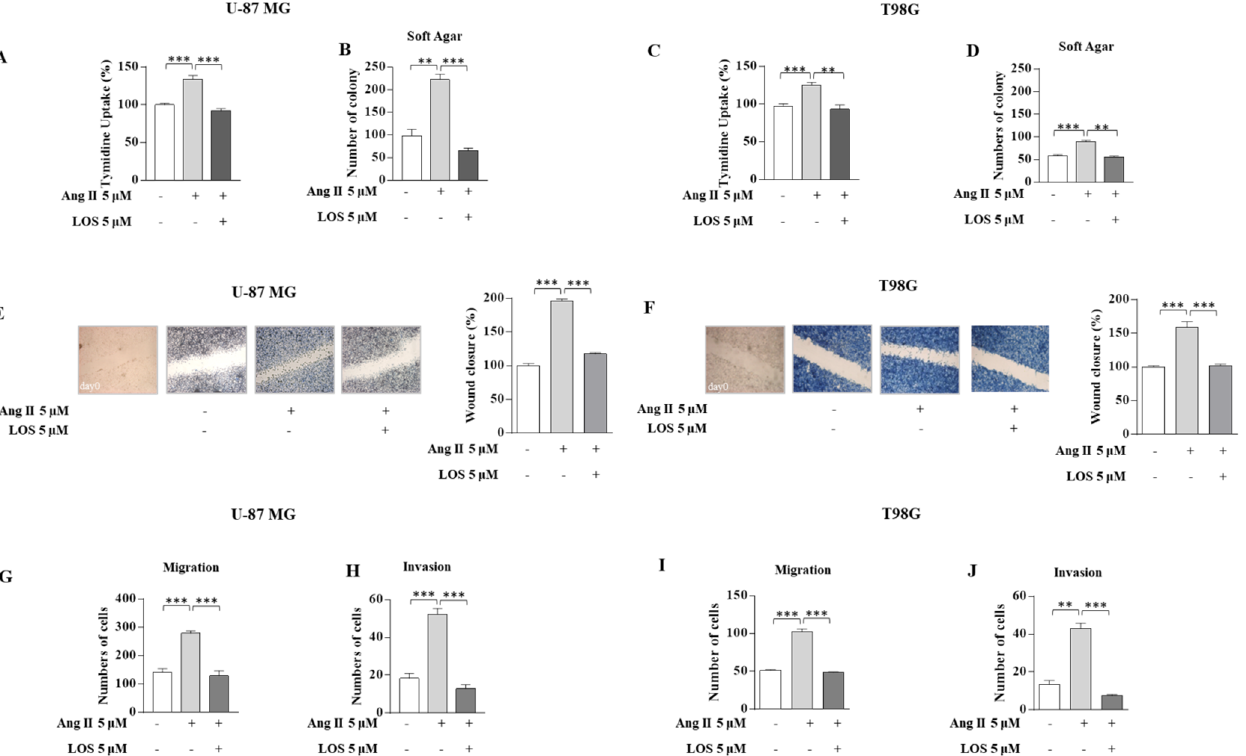
Figure 4. Effects of LOS on Ang II-induced U-87 MG and T98G glioblastoma cell proliferation, migration, and invasiveness. Cell proliferation was determined by the [3H] thymidine ( A , C ) and soft agar growth ( B , D ) assays in U-87 MG and T98G glioblastoma cells treated with vehicle (−) and Ang II 5 µM alone or in combination with LOS 5 µM for 24 h. ( E , F ) Wound-healing assays in U-87 MG and T98G glioblastoma cells treated for 12 h with vehicle (−) and Ang II 5 µM alone or in combination with LOS 5 µM. Images are representative of three independent experiments. The percentage of wound closure has been represented on histograms calculated using ImageJ software version 1.51q. Squares, time 0. Original magnification, ×10. Boyden chamber transmigration ( G , I ) and invasion ( H , J ) assays in U-87 MG and T98G glioblastoma cells treated with vehicle (−) and Ang II 5 µM alone or in combination with the LOS 5 µM for 12 h. Data represent the mean ± SD of three different experiments, each performed in triplicate. ** p < 0.01; *** p < 0.001.